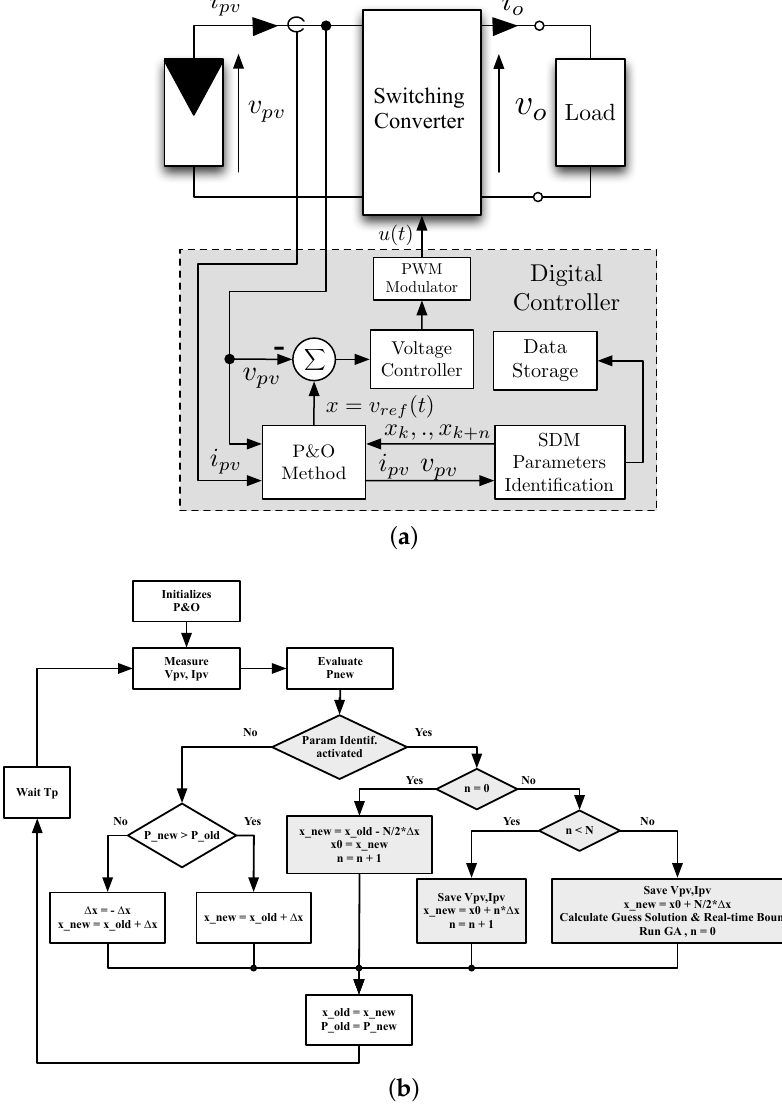
Figure 8. Photovoltaic system with the MPPT and online parameter identification technique. ( a ) Functional scheme of the proposed digital controller; ( b ) flowchart of the perturb and observe algorithm integrated with the parameter identification